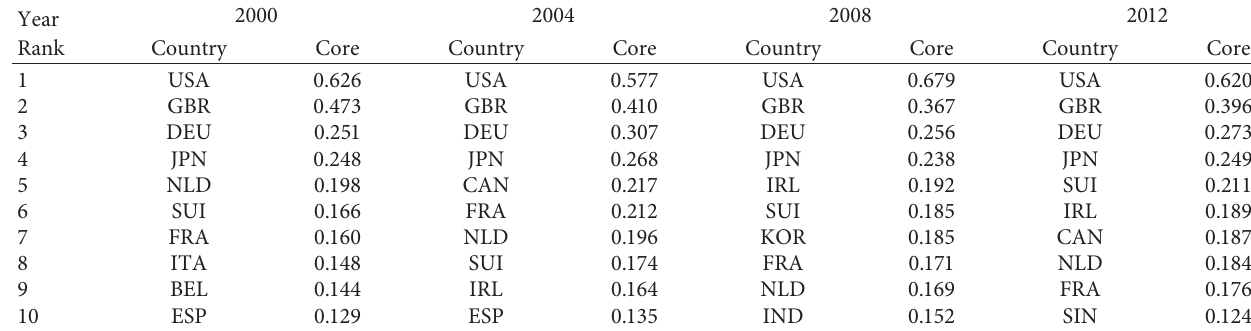
Table 7: Core degree of the producer services trade network (Top 10).